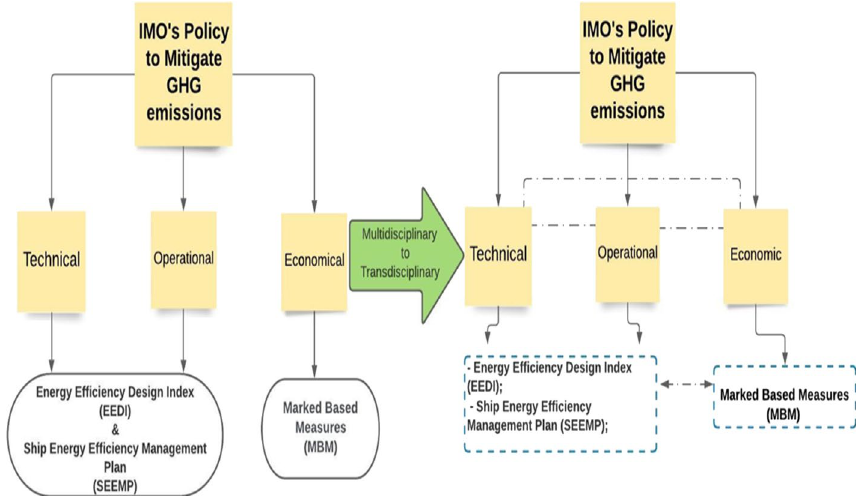
Fig. 1 A transdisciplinary approach to mitigation of air emissions from